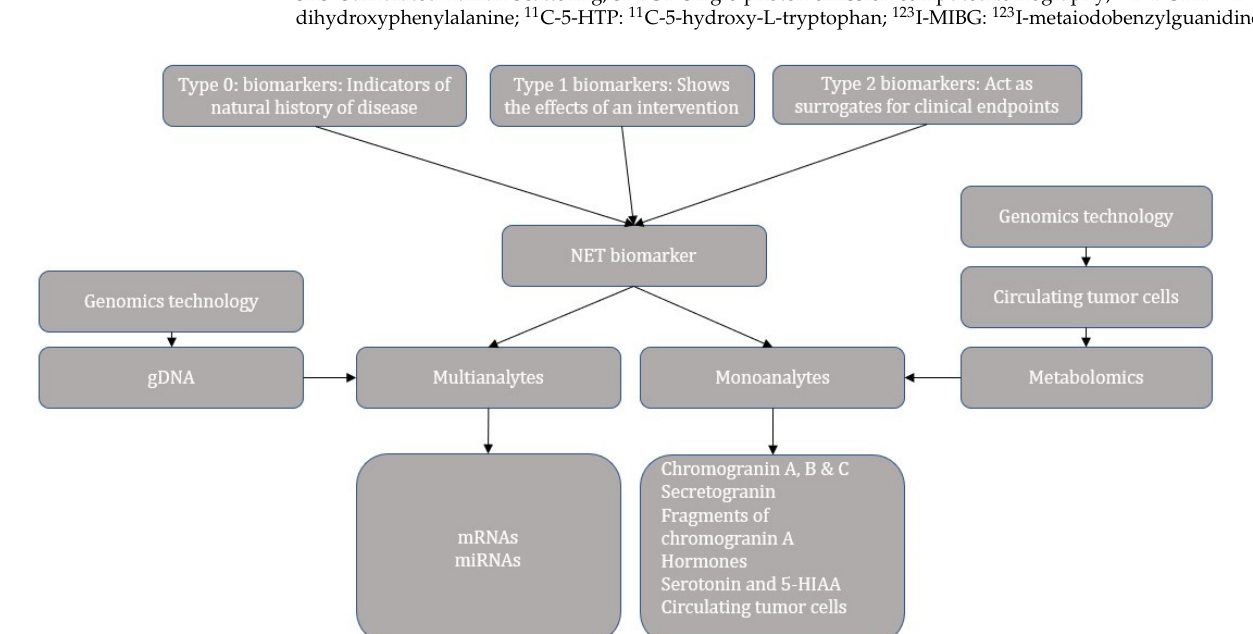
Figure 1. Categories and progress overview of neuroendocrine tumor biomarkers.